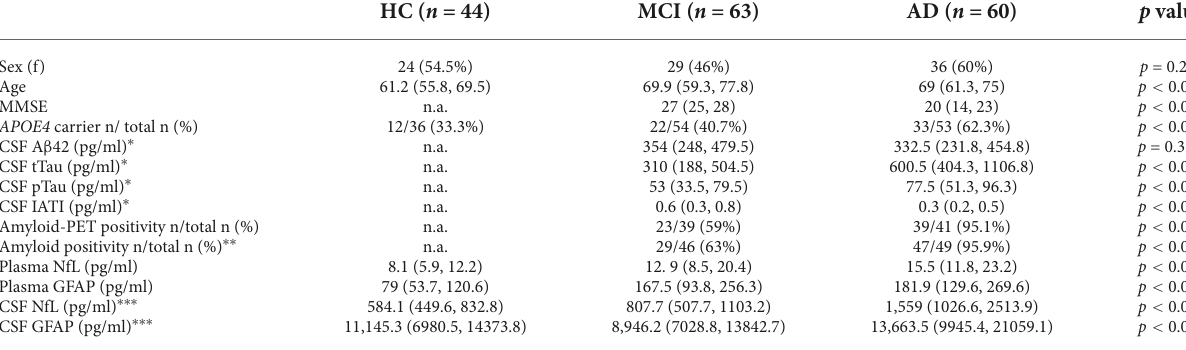
TABLE 1 Demographics and clinical characteristics.